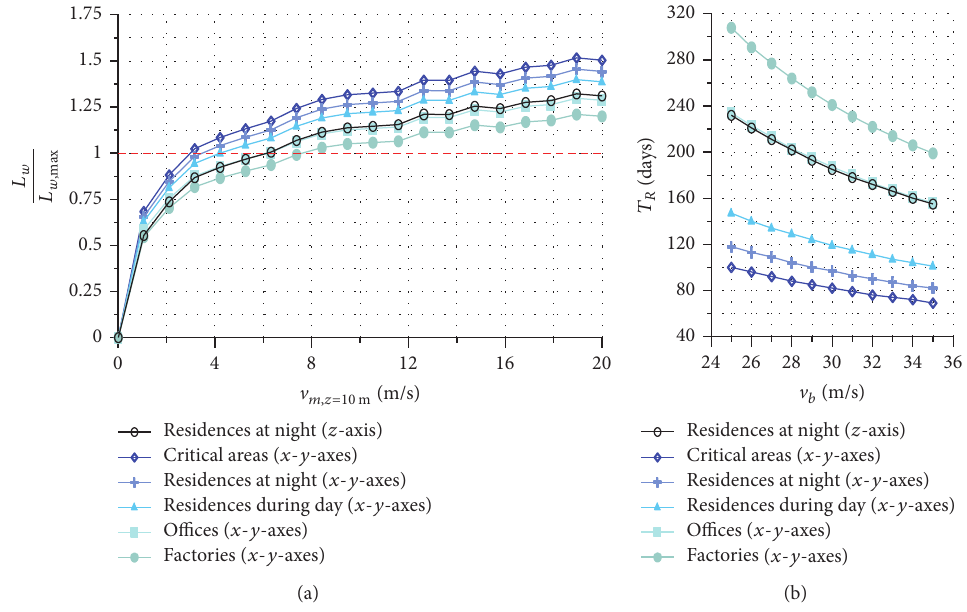
Figure 5: Results of vibration comfort analysis for the case study of Table 3: ratio between the total frequency weighted acceleration, 𝐿 𝑤 , and the critical limit, 𝐿 𝑤, max , versus the ten-minute mean wind velocity at 10m height (a); return period of the critical wind velocity determining discomfort versus the basic wind velocity of the site